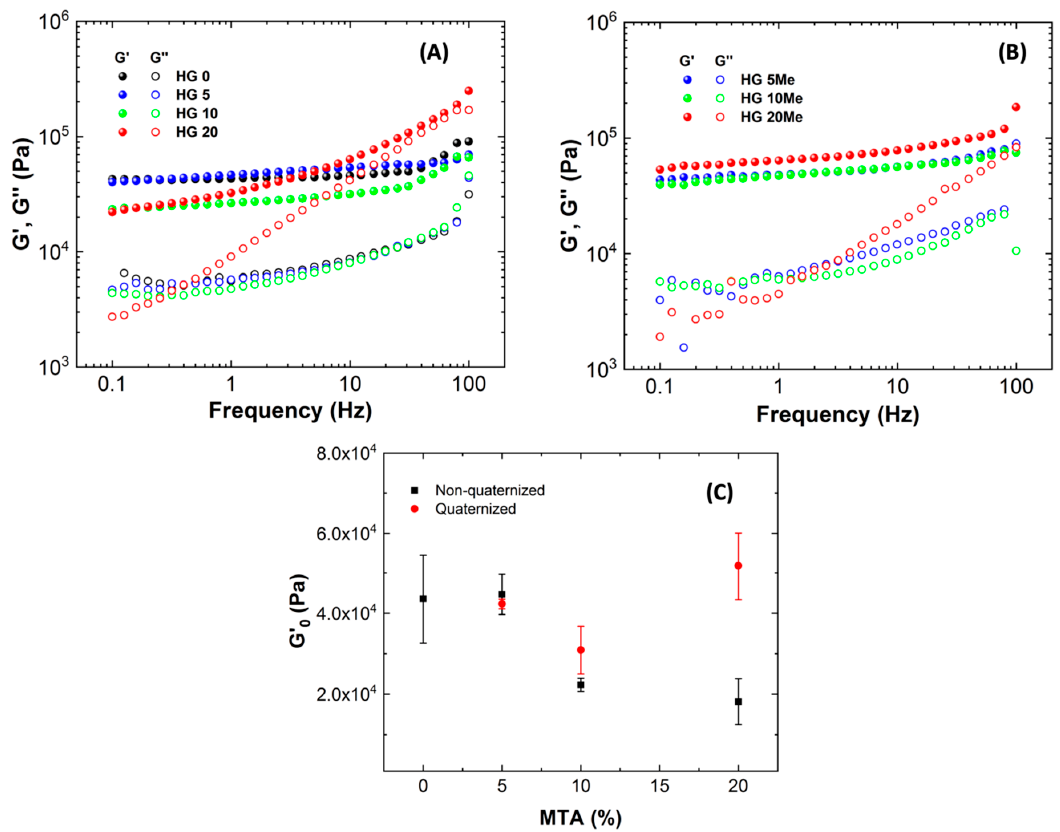
Figure 5. The storage and loss (G ′ and G ″ ) moduli as a function of frequency (G ′ solid and G ″ open symbols) for ( A ) unmodified, ( B ) methylated hydrogels and ( C ) describes the evolution of elastic modulus plateau (G ′ 0 ) as a function of 2-(4-methylthiazol-5-yl)ethyl methacrylate (MTA) percentage for non-quaternized and quaternized hydrogels.